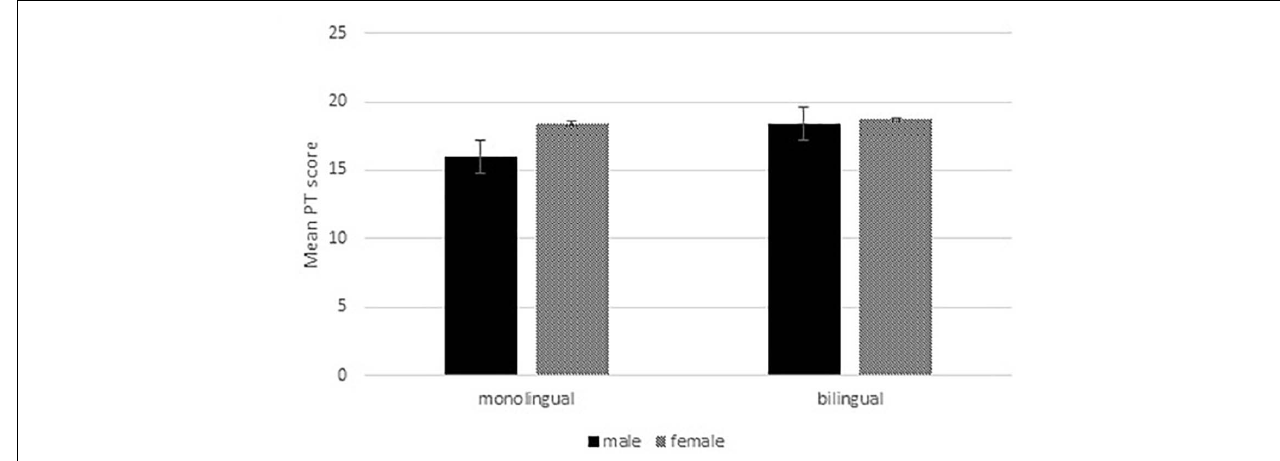
FIGURE 1 | Effect of gender (male vs. female) and bilingualism (bilingual vs. monolingual) on PT scores (range 0–28). Error bars represent standard errors.